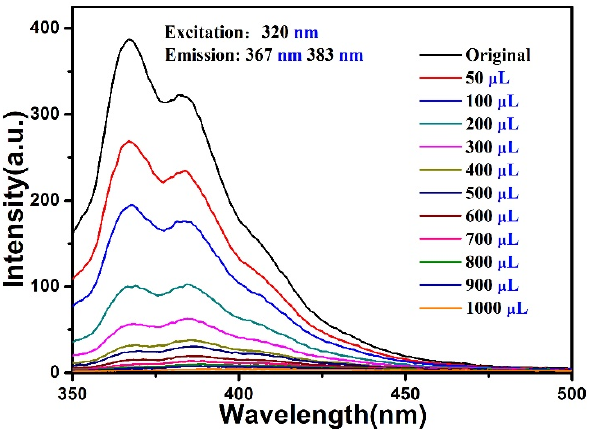
Figure 6. Fluorescence spectra of the compound with addition of Fe 3+ (5 × 10 − 3 M).